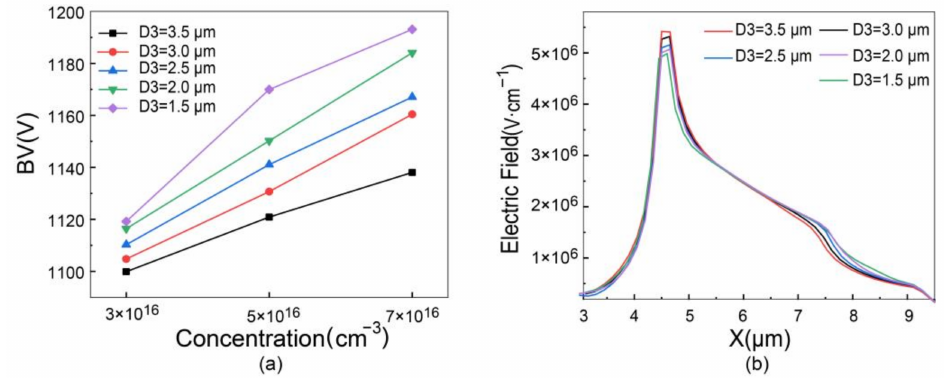
Figure 8. ( a ) The effect of D3 on BV; ( b ) the electric field distribution at V ds = 650 V with 7 × 10 16 cm − 3